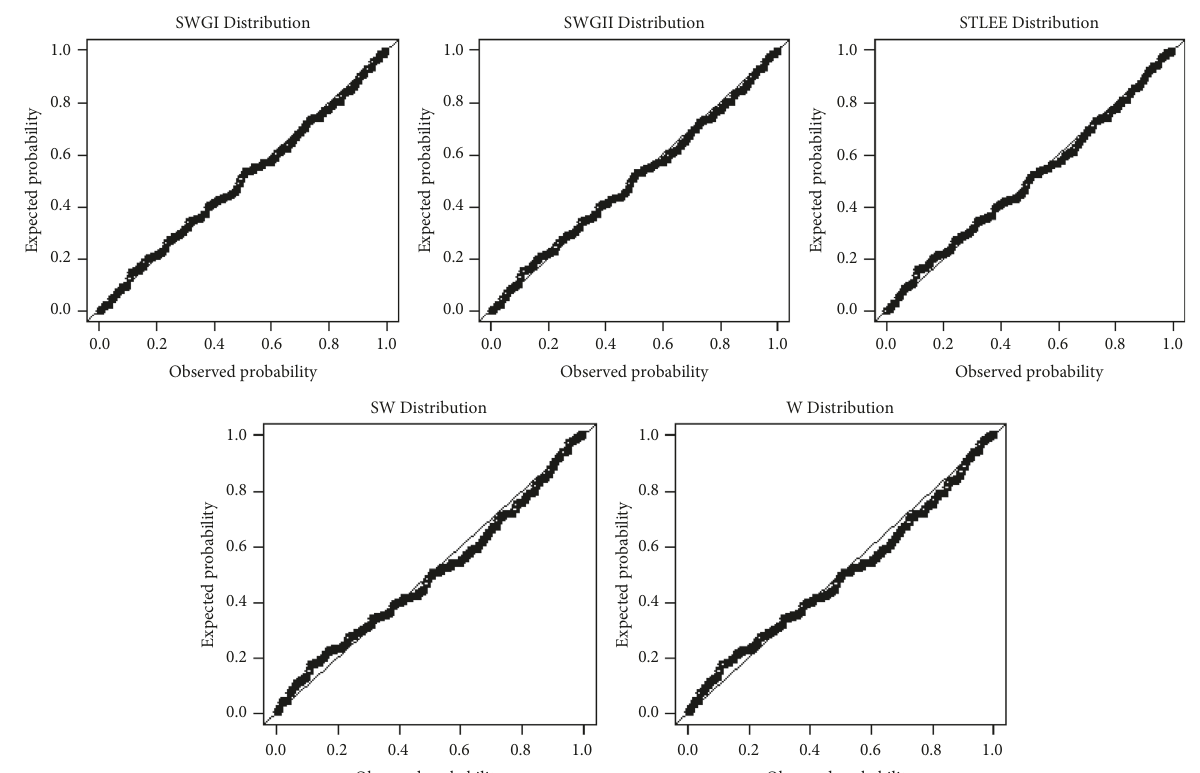
Figure 4: P-P plots of fitted